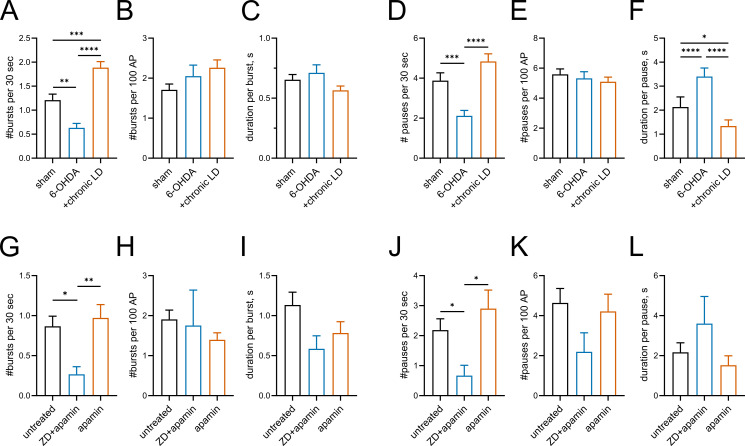
Burst-pause activity in ChIs.The number and duration of bursts and pauses were quantitated using the robust Gaussian surprise method. (A–F) Firing patterns of ChIs from sham (n = 83 neurons/26 mice), 6-OHDA (n = 81 neurons/29 mice, and chronic-LD (n = 87 neurons/25 mice) groups. (G–L) Firing patterns of ChIs in untreated mouse brain slices (n = 17 neurons/6 mice), those treated with 1 μM ZD7288 and 1 nM apamin (n = 8 neurons/3 mice) or the same concentration of apamin alone (n = 10 neurons/3 mice). p<0.05 (*), p<0.01 (**), p<0.001 (***), p<0.0001 (****) by Kruskal-Wallis test with Dunn’s multiple comparison. Burst duration (C and I) and pause duration (F and L) were analyzed only in neurons exhibiting bursts and pauses: sham n = 66, 75; 6-OHDA n = 52, 64; chronic-LD n = 80, 85; untreated n = 17, 16; ZD+apamin n = 6, 8; apamin n = 10, 10 (bursts, pauses). Blockade of HCN and SK currents largely reproduced changes in firing patterns observed in the 6-OHDA and chronic LD groups. Also note that number of bursts and pauses was not different between any groups when bursts or pauses were normalized to the number of action potentials (B,H,E,K), suggesting that the expression of bursts and pauses is related to the change in the firing rate.